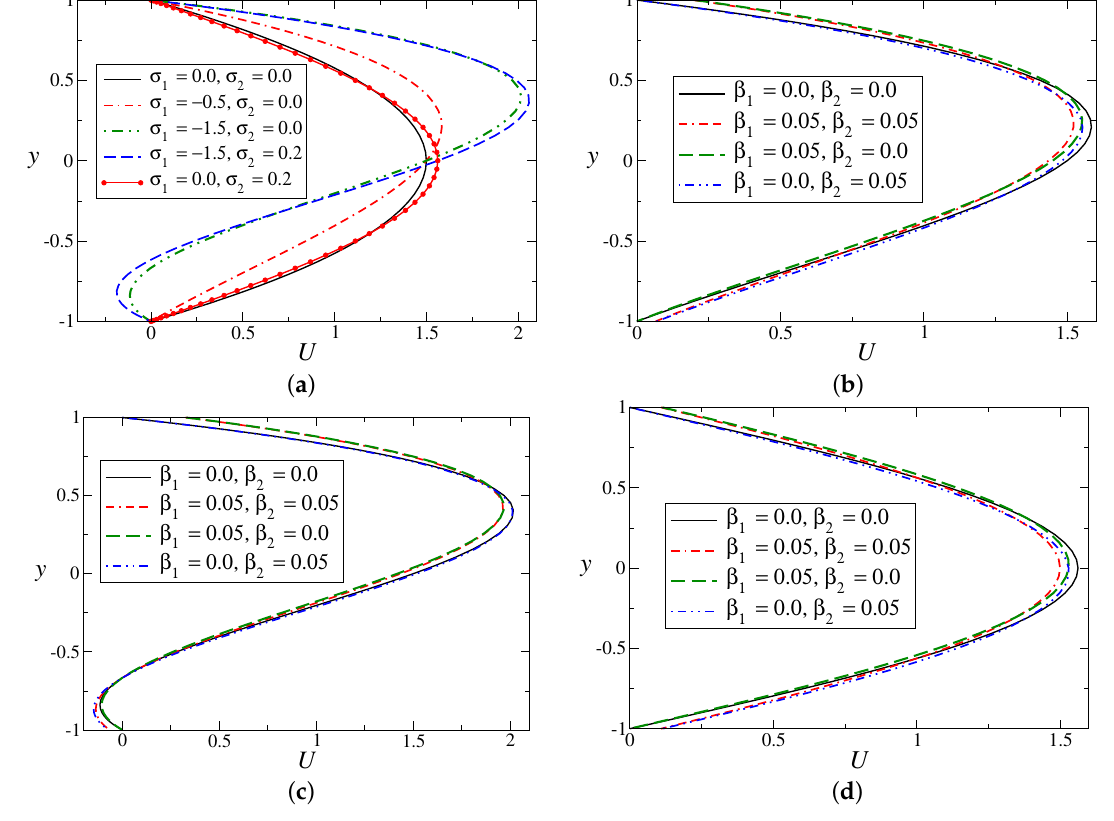
Figure 2. Mean velocity profiles U ( y ) for: ( a ) β 1 = β 2 = 0.0, different σ 1 and σ 2 ; ( b ) σ 1 = − 0.5, σ 2 = 0.0; ( c ) σ 1 = − 1.5, σ 2 = 0.0; and ( d ) σ 1 = 0.0, σ 2 = 0.2. ( b – d ) contain slip cases results.